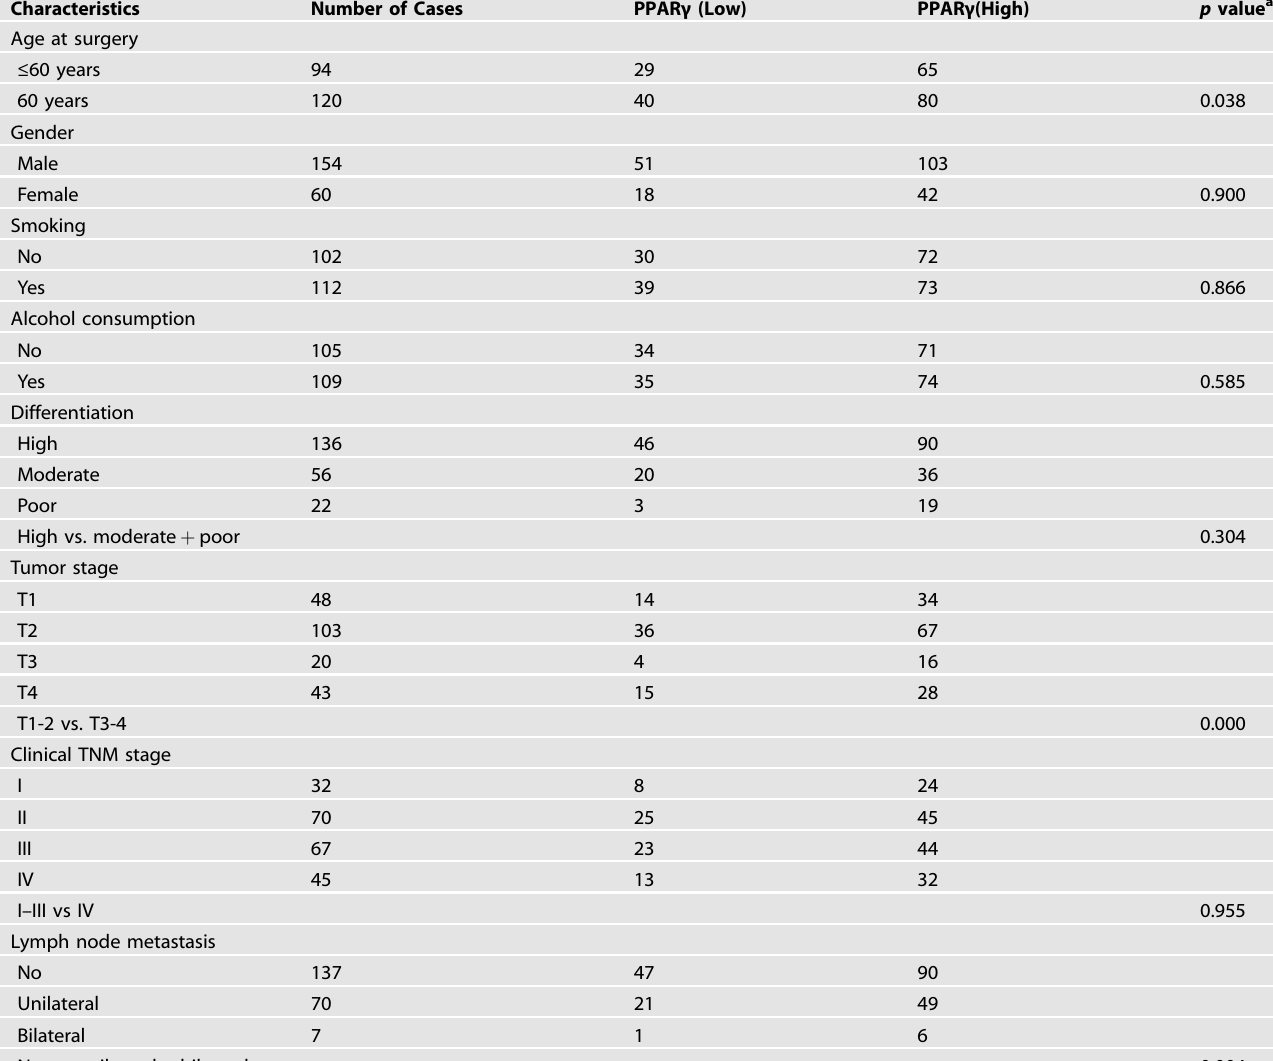
Table 2. Correlation of PPAR γ in HNSCC with clinicopathological factors including patients and tumor